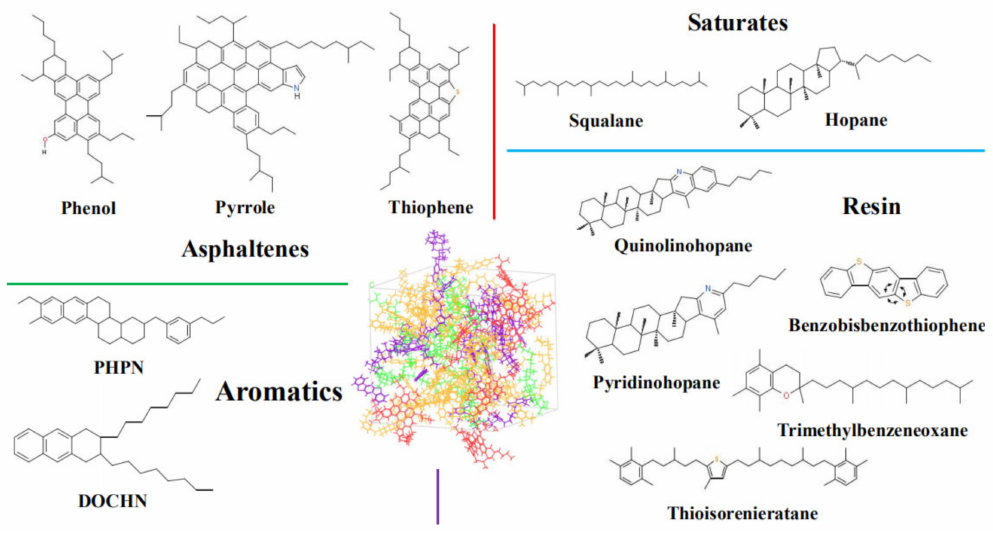
Figure6. The12-componentasphaltmodel(asphaltene: red,resin: purple,saturate: green,aromatic:yellow). Table 3. Detailed compositions of saturates, aromatics, resins, and asphaltenes (SARA)-component asphalt model